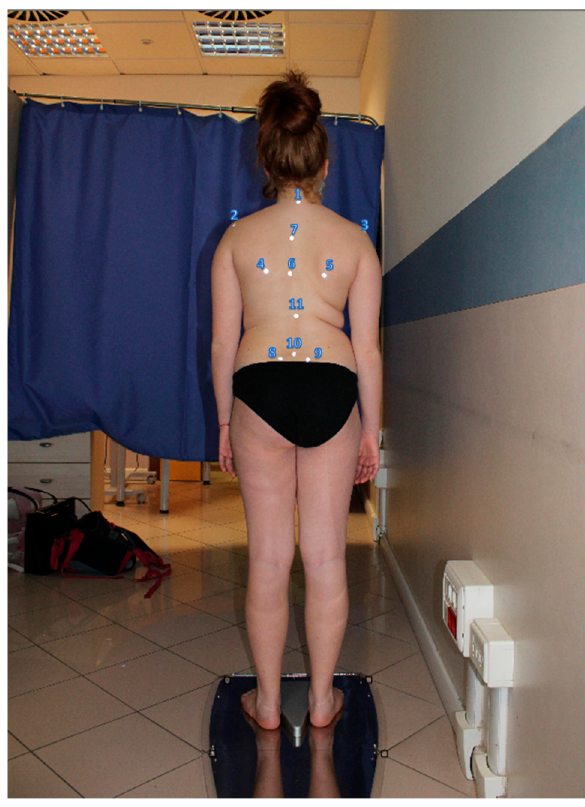
Figure 3. Set point positions.